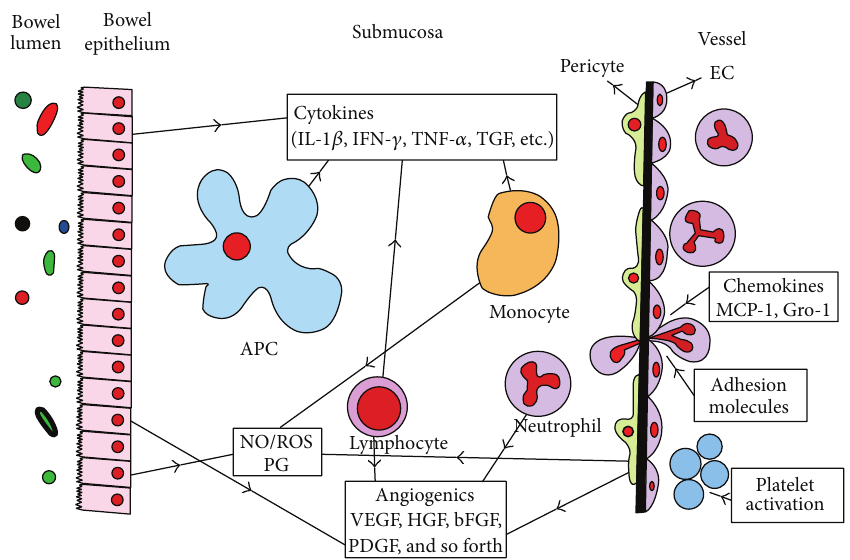
Figure 2: Relationship between bowel lumen, endothelium, immune cells, and vessel in immune-driven angiogenesis in inflammatory bowel disease. bFGF: basic fibroblast growth factor; Gro-1: growth-regulated oncogene-1; HGF: hepatocyte growth factor; IFN: interferon; IL: interleukin; MCP-1: monocyte chemoattractant protein; NO: nitric oxide; PDGF: platelet-derived growth factor; PG: prostaglandin; ROS: reactive oxygen species; TGF: transforming growth factor; TNF: tumor necrosis factor; VEGF: vascular endothelial growth